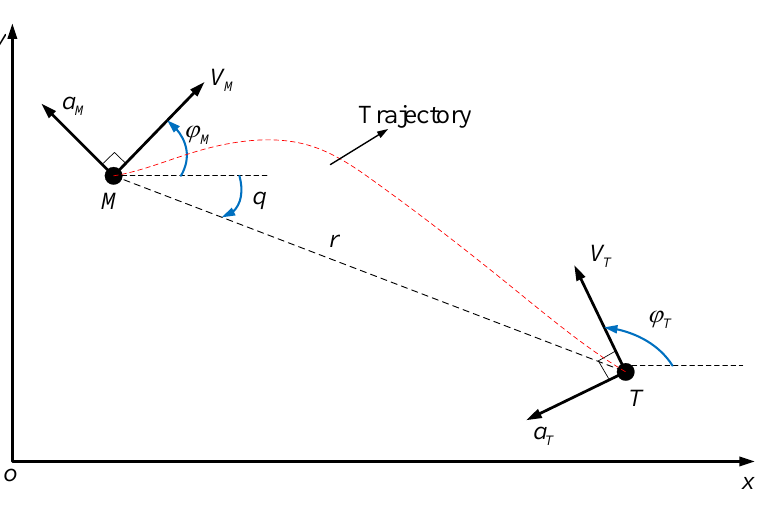
Figure 1. Planar missile–target